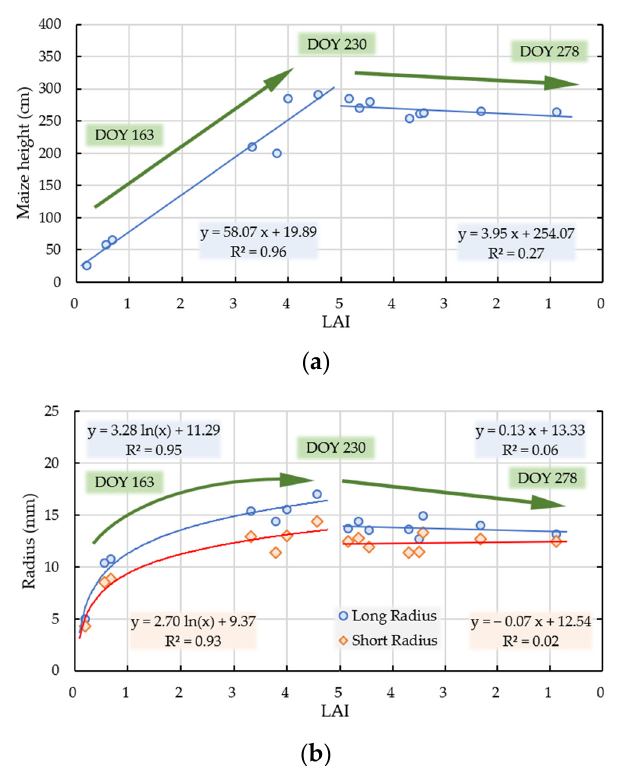
Figure 3. The allocation characteristics, fitted equations, and segmentation points of the maize geometric parameters including ( a ) maize height and ( b ) long and short radius for the entire growing season.